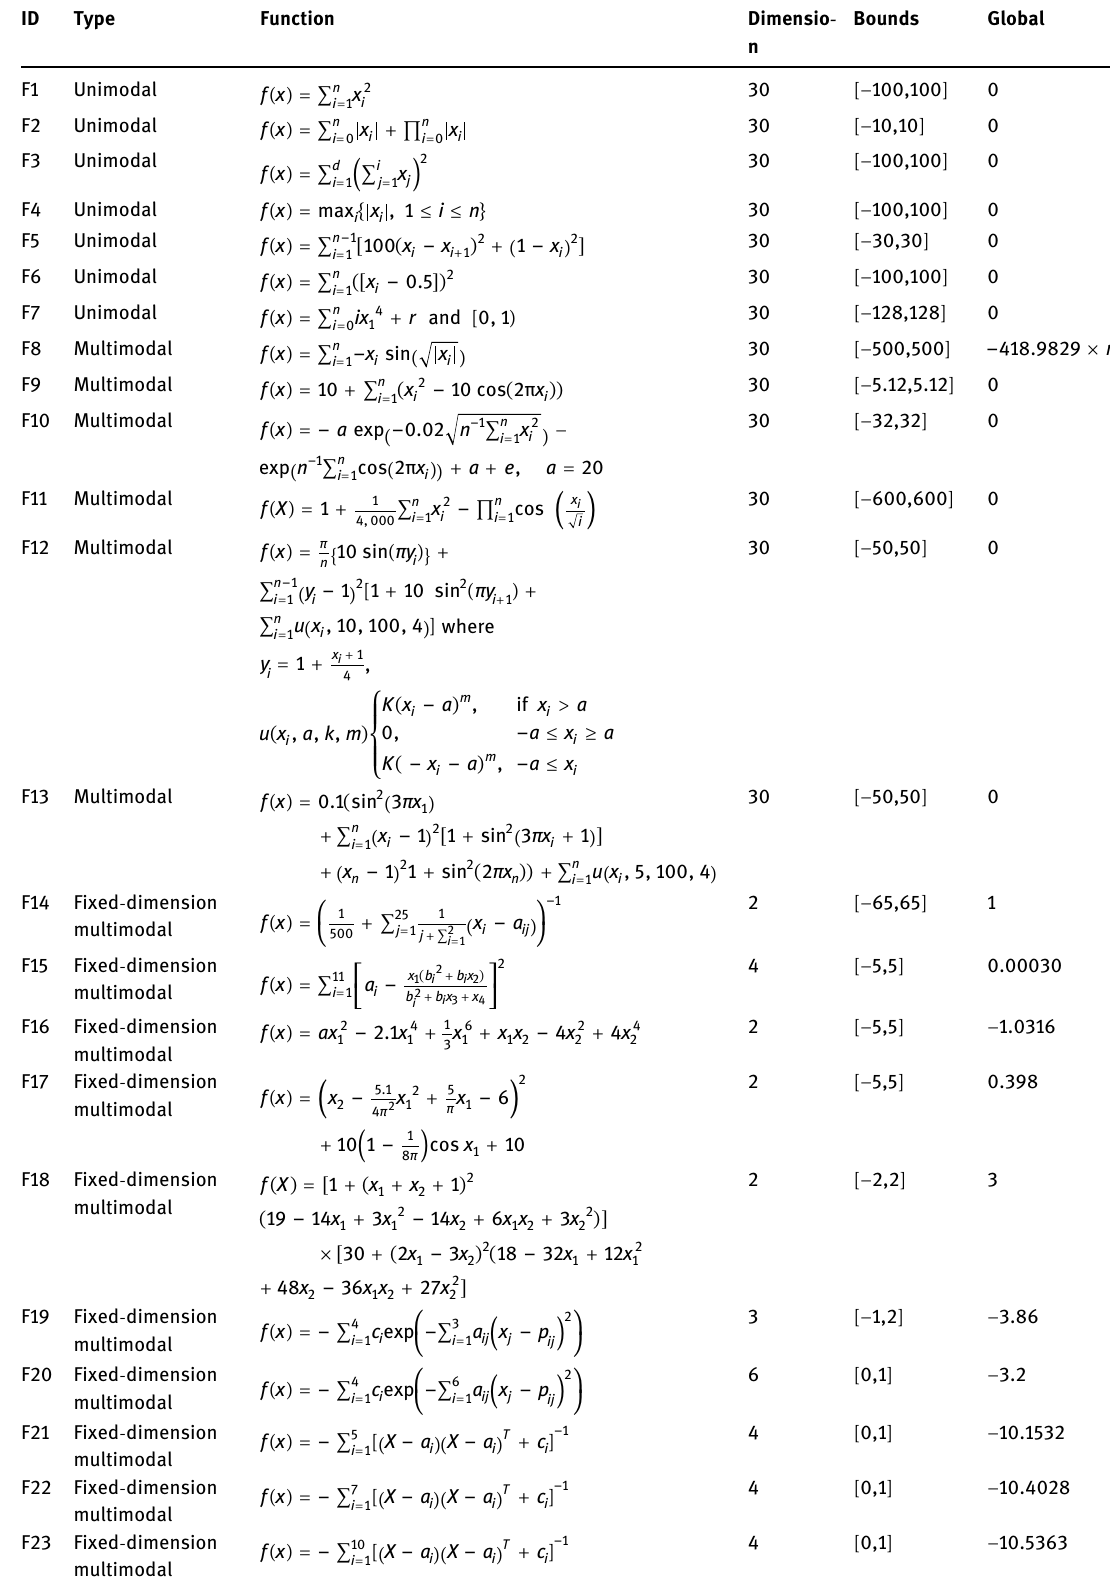
Table 1: Classical test